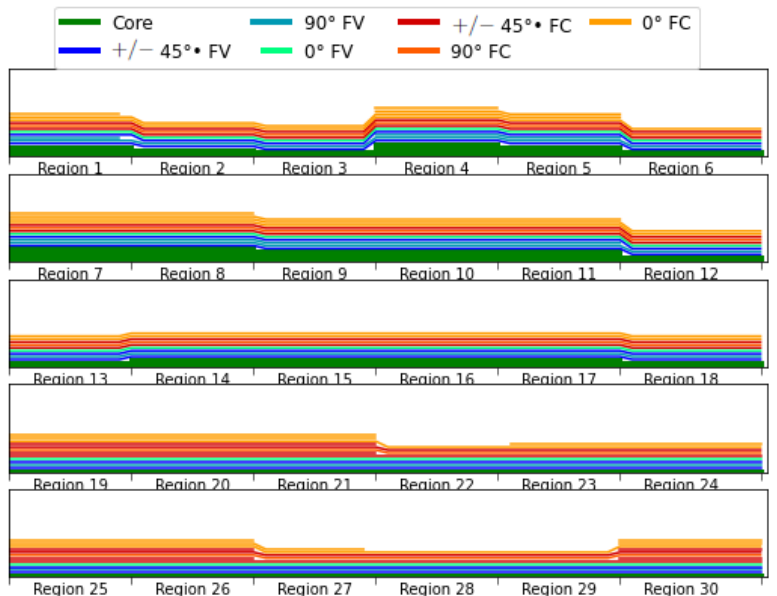
Figure 22. Schematic representation of the laminate selected through MCDM from the MOSOP4